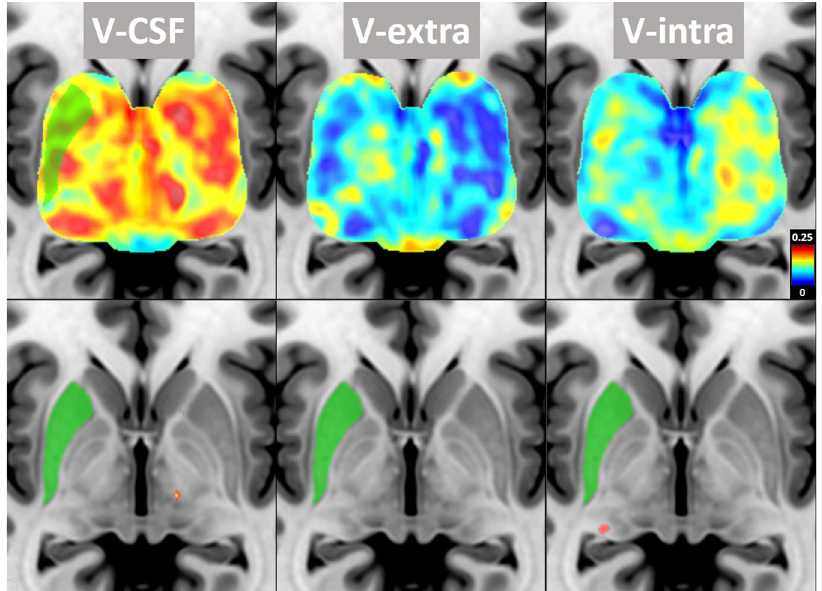
Fig. 2 Voxel-wise group comparison of putaminal microstructure between patients with PD and healthy controls. Voxel-wise group comparison of DMI parameters between patients with PD ( n = 108) and healthy controls ( n = 35) superimposed on a T1w MRI template in standard space. The analysis controlled for age and sex, and a 5% false discovery rate (FDR) was applied. Top row: The standardized regression coef fi cients were extracted from regression models both in PD and HC groups (with the covariates “ age ” and “ sex ” ). Color-coding indicates the coef fi cient values as a measure of effect size of the factor “ Parkinson ’ s disease ” on DMI-parameters (hot colors: positive effect size vs. cold colors: negative effect size). Bottom row: Signi fi cant results of the voxel-wise group comparisons with a 5% FDR. The right putamen is shown in green. The left side of the image corresponds to right side of the patient ’ s body. DMI diffusion microstructure imaging, FDR false discovery rate, V-CSF compartment of free interstitial fl uid, V-extra compartment of somata and unmyelinated axons, V-intra intra-axonal and dendritic